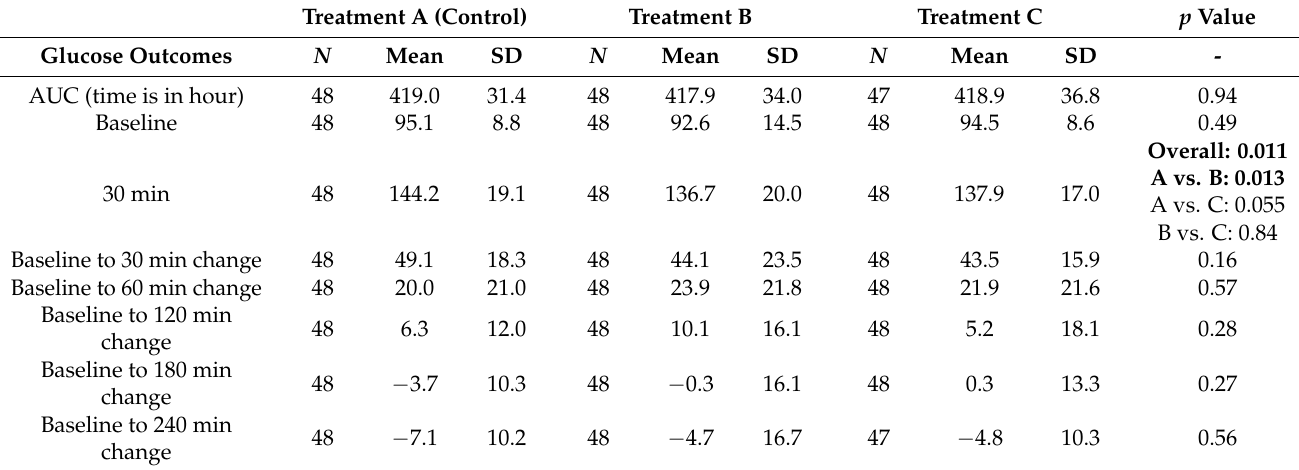
Table 2. Blood glucose statistical analysis of three treatments across all time